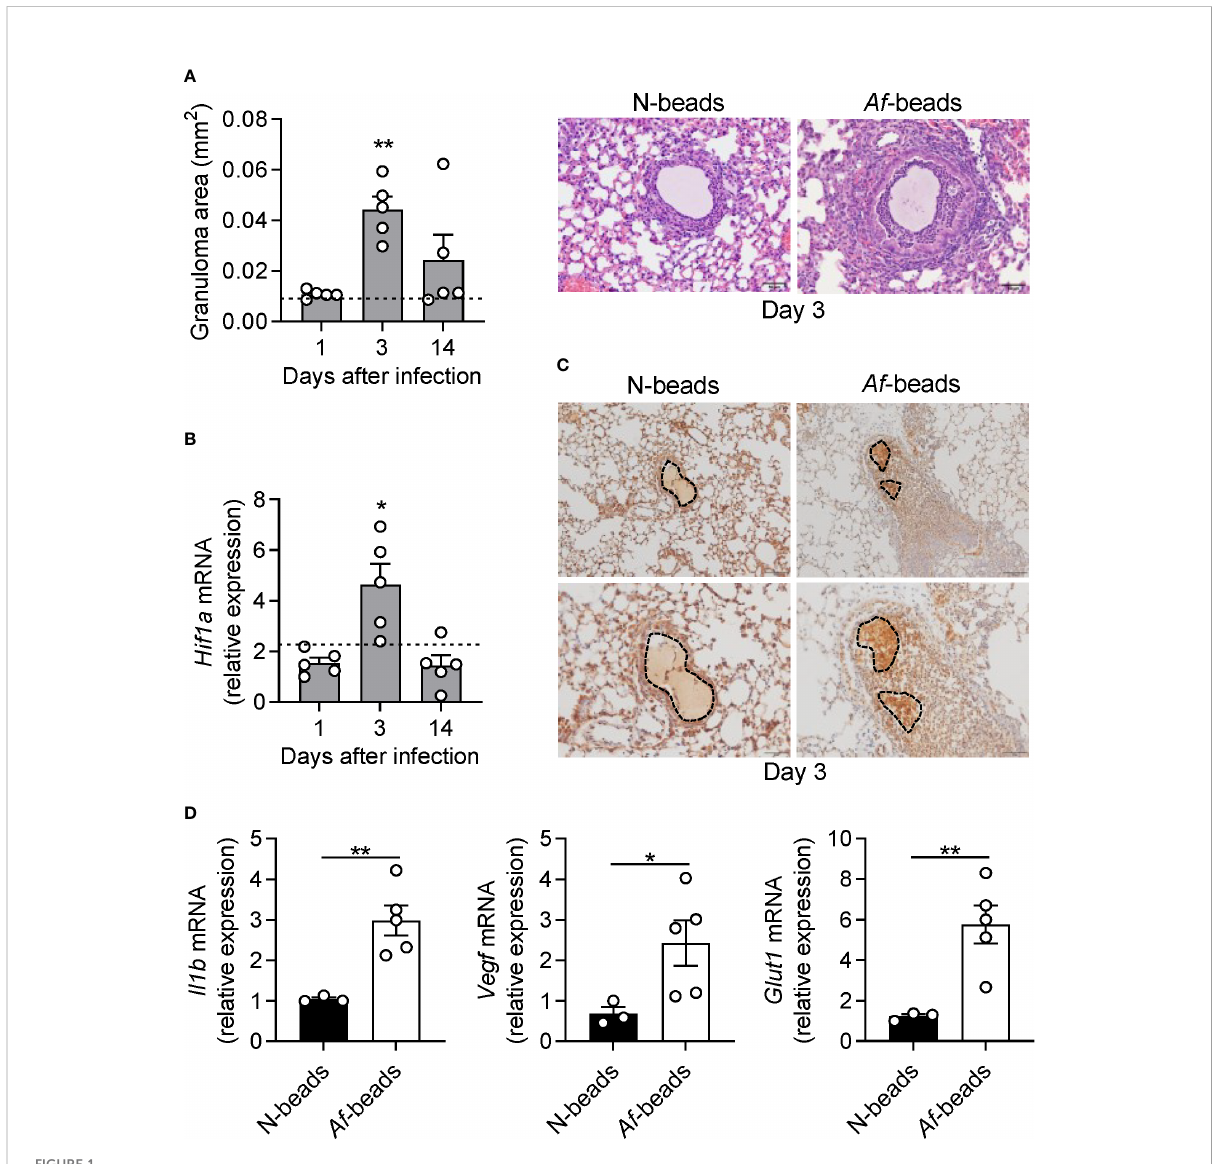
FIGURE 1 HIF-1 a is induced upon in vivo development offungal elicited granuloma-like structures. (A) Granuloma area around beads containing A. fumigatus conidia ( Af -beads) after 1, 3 and 14 days post-infection (n = 5). The dotted line represents the mean value of naked bead (N-beads) granulomas after 3 days post-infection (n = 5). Representative hematoxylin and eosin (H&E) staining of mouse lung sections challenged with Af -beads or N-beads after 3 days post-infection are shown. Scale bar represents 50 m m. (B) Lung mRNA expression of Hif1a after 1, 3 and 14 days post-infection with Af -beads (n = 5). The dotted line represents the mean value of Hif1a expression after 3 days post-infection with N-beads (n = 5). (C) Representative immunohistochemistry staining for HIF-1 a in lung sections of mice after 3 days post-infection with Af -beads or N-beads. Scale bar represents 50 m m. (D) Lung mRNA expression of Il1b , Vegf and Glut1 after 3 days post-infection with Af -beads or N-beads (n = 5). *P < 0.05; **P <